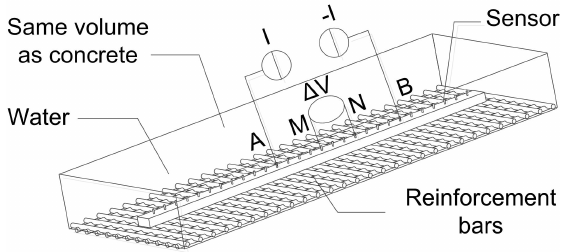
Figure 9. Principle of measurement and schematic view of the experimental